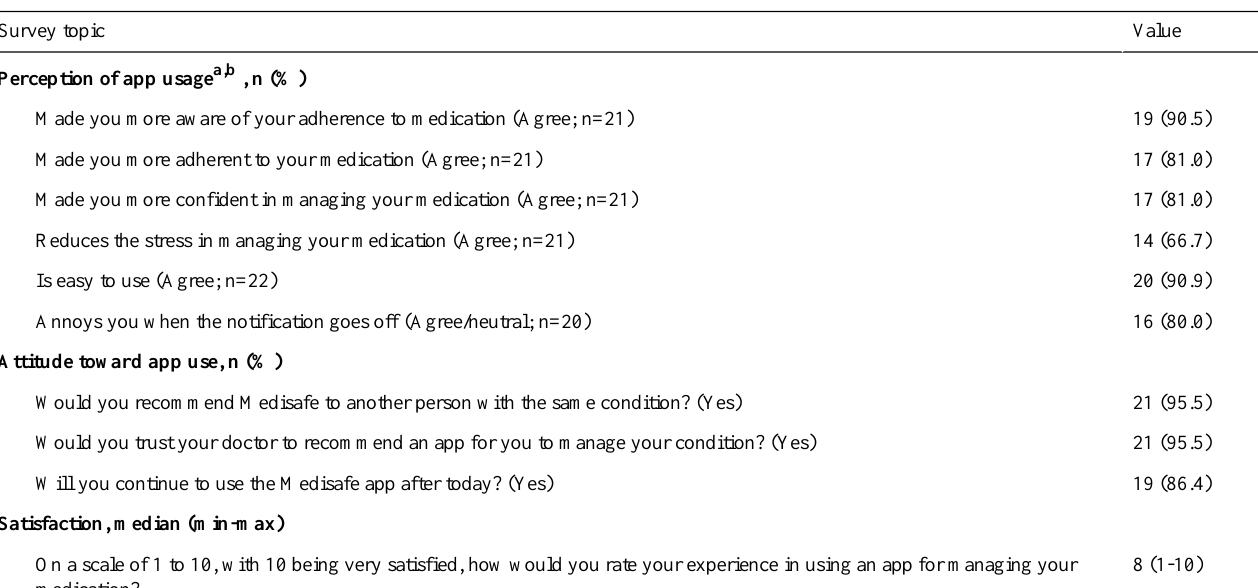
Table 3. Perception, attitude, and satisfaction of app use in the intervention